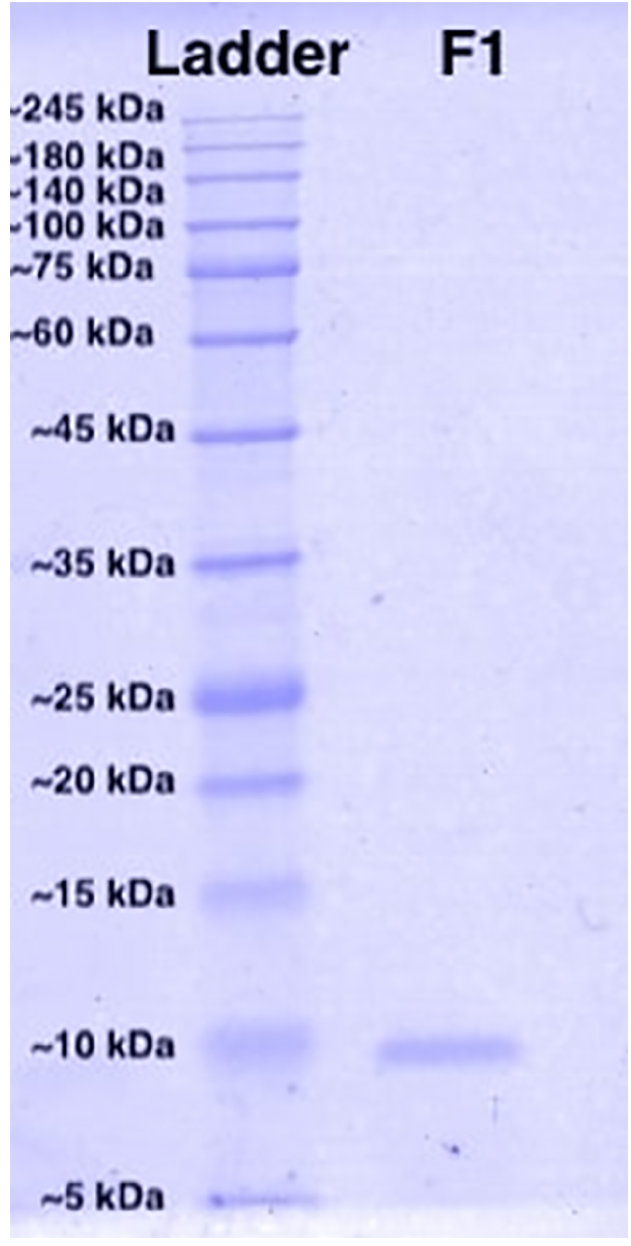
Figure 3. Protein content of Fraction 1 (F1) of Malaysian T. purpureomaculatus venom was validated under 15% reducing gel electrophoresis. Protein ladder PM2700 ExcelBand™ 3-color Broad Range Protein Marker was used for molecular weight standards (5−245 kDa).